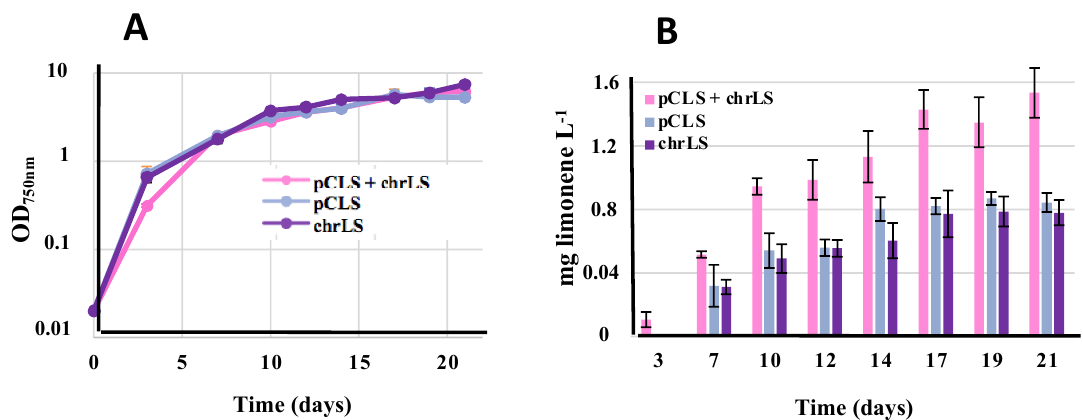
Figure 5. Simultaneous analysis of growth ( A ) and terpene production ( B ) of the Synechococcus PCC 7002 strains harboring the strongly expressed limonene synthase gene (LS) in either or both the replative plasmid (pCLS) or a neutral chromosomal site (chrLS). Cells were grown under standard photoautotrophic conditions in the presence of a dodecane overlay (20% vol/vol) to assay terpene production for 21 days. Error bars represent standard deviation from biological triplicates.